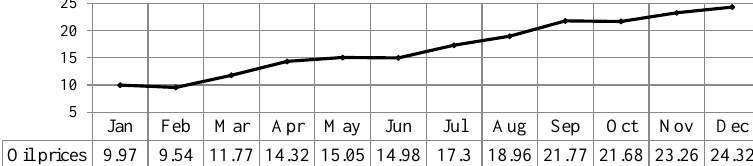
Figure 3. Iran’s heavy crude oil prices (per barrel) in